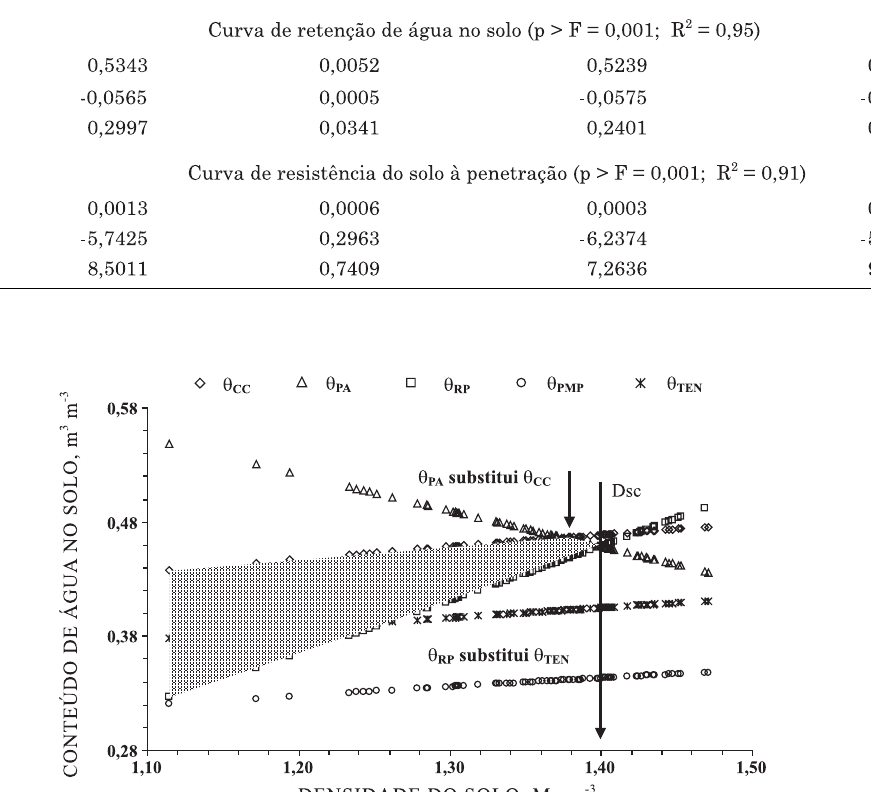
Figura 1. Variação do conteúdo de água com a densidade do solo em relação à capacidade de campo ( θθθθθ porosidade de aeração ( θθθθθ ), à resistência do solo à penetração ( θθθθθ PA ( θθθθθ ) e ao potencial de -800 hPa ( θθθθθ ) adotado para controle de PMP TEN